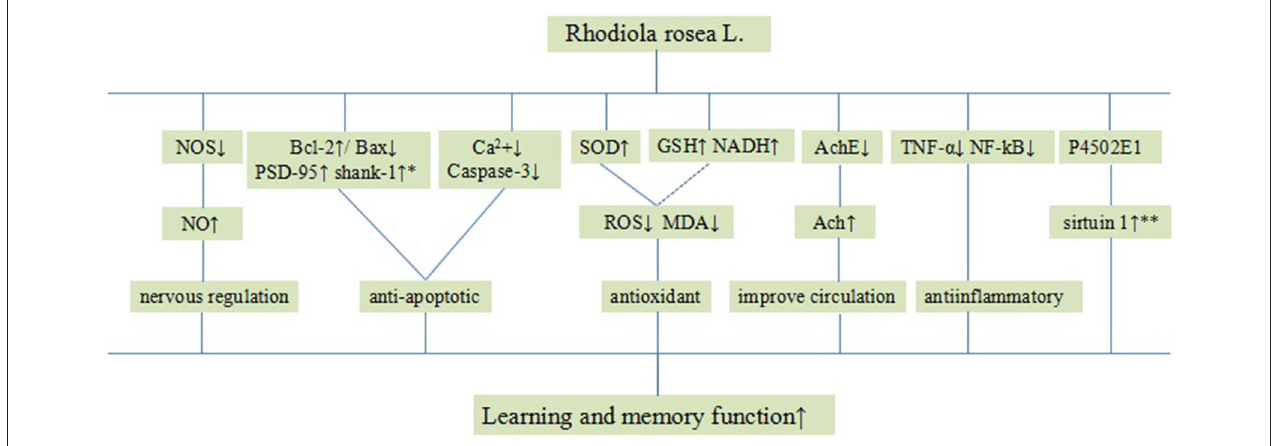
FIGURE 12 | A schematic representation of possible mechanisms of Rhodiola rosea L. for improving learning and memory function. Solid lines indicate established effects, whereas dashed lines represent putative mechanisms. *The expression of Bcl-2, Bax protein, PSD-95 and shank-1 protein in the hippocampus; **The activity of sirtuin